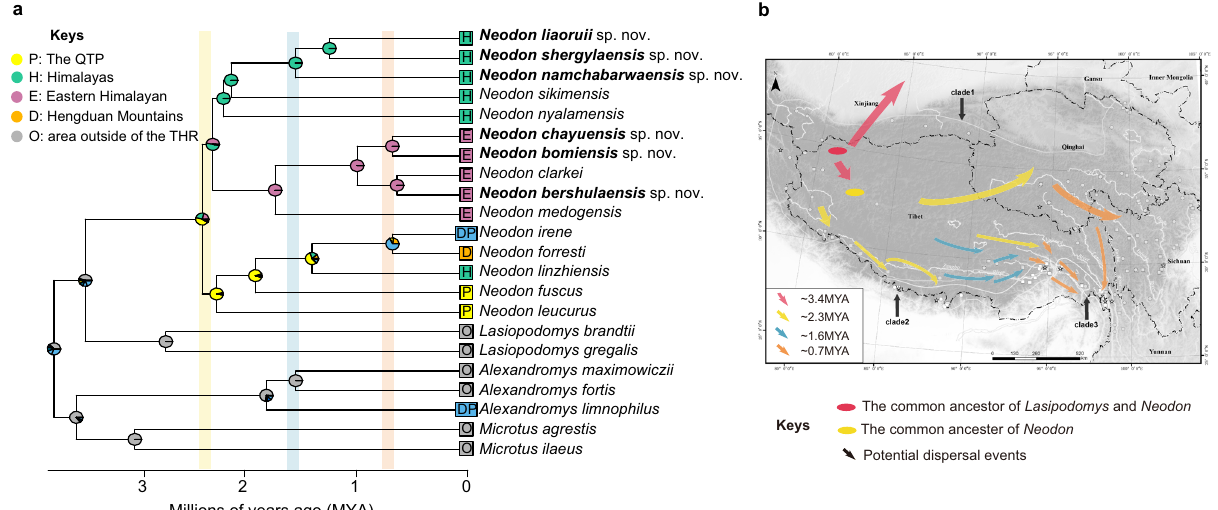
Fig. 4 Ancestral range estimation of Neodon . a Ancestral range estimation based on the best- fi tting model DEC + J implemented in BioGeoBEARS. The relative probabilities of each ancestral reconstruction are indicated with pie charts at each node. New species denoted in bold. Transparent bars represent the timelines following the coding described in b. b Estimated origin and dispersal of extant Neodon .